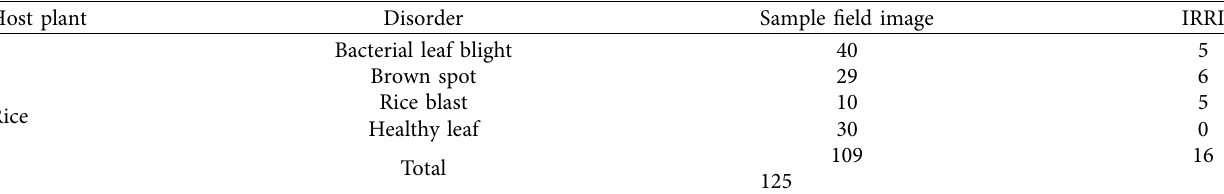
Figure 5: Rice plant statistics. (a) Bacterial leaf blight, (b) brown spot, (c) rice blast, and (d) healthy leaf. Table 1: Total dataset of this research